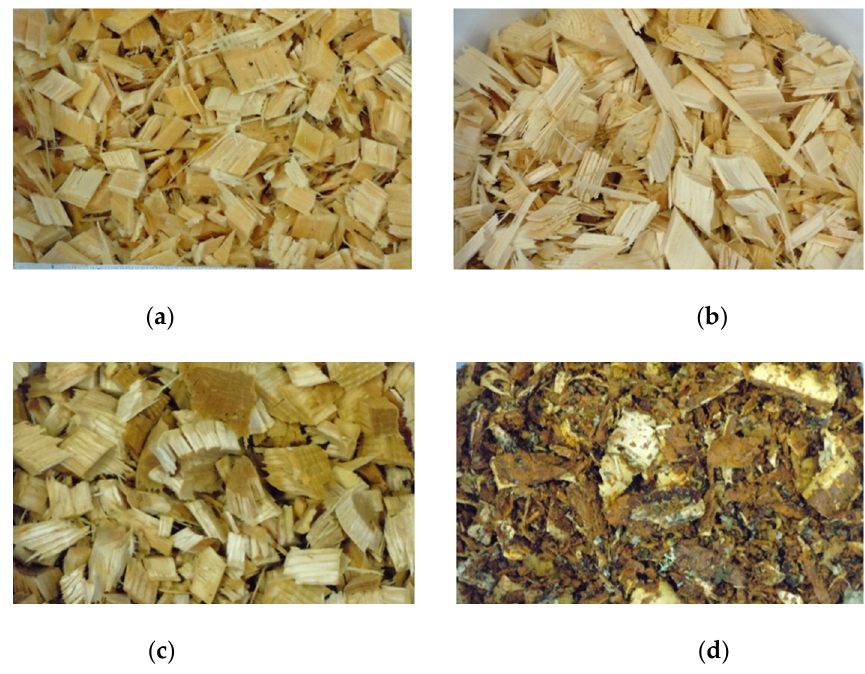
Figure 1. Studied materials: ( a ) Pine sapwood; ( b ) Pine heartwood; ( c ) Birch chips; ( d ) Birch bark.